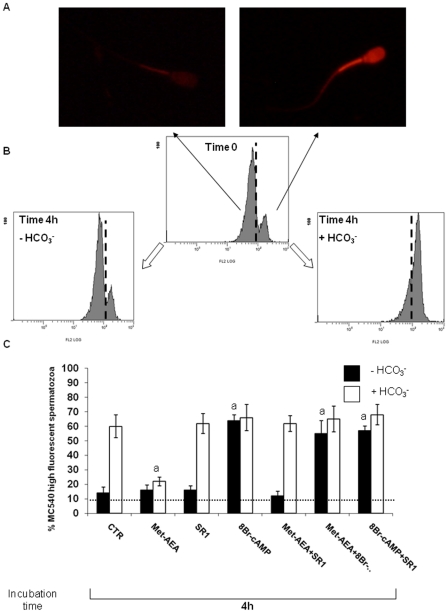
MC540 staining of spermatozoa incubated under capacitating conditions or upon different treatments.MC540 fluorescence increases with the increase of membrane scrambling. Panel A) Picture showing a MC540 negative spermatozoon (on the left) and a MC540 positive spermatozoon (on the right). Panel B) flow cytometry graphics showing the different population, low and high fluorescence emission (divided by black dot line) found in relation to different cultural conditions. Panel C) Effect of different treatments on the percentage of MC540 positive spermatozoa, at the beginning (Ejaculated sptz) and at the end of culture (In vitro incubated sptz). a = p<0.01 vs. other 4 h samples, ANOVA test.